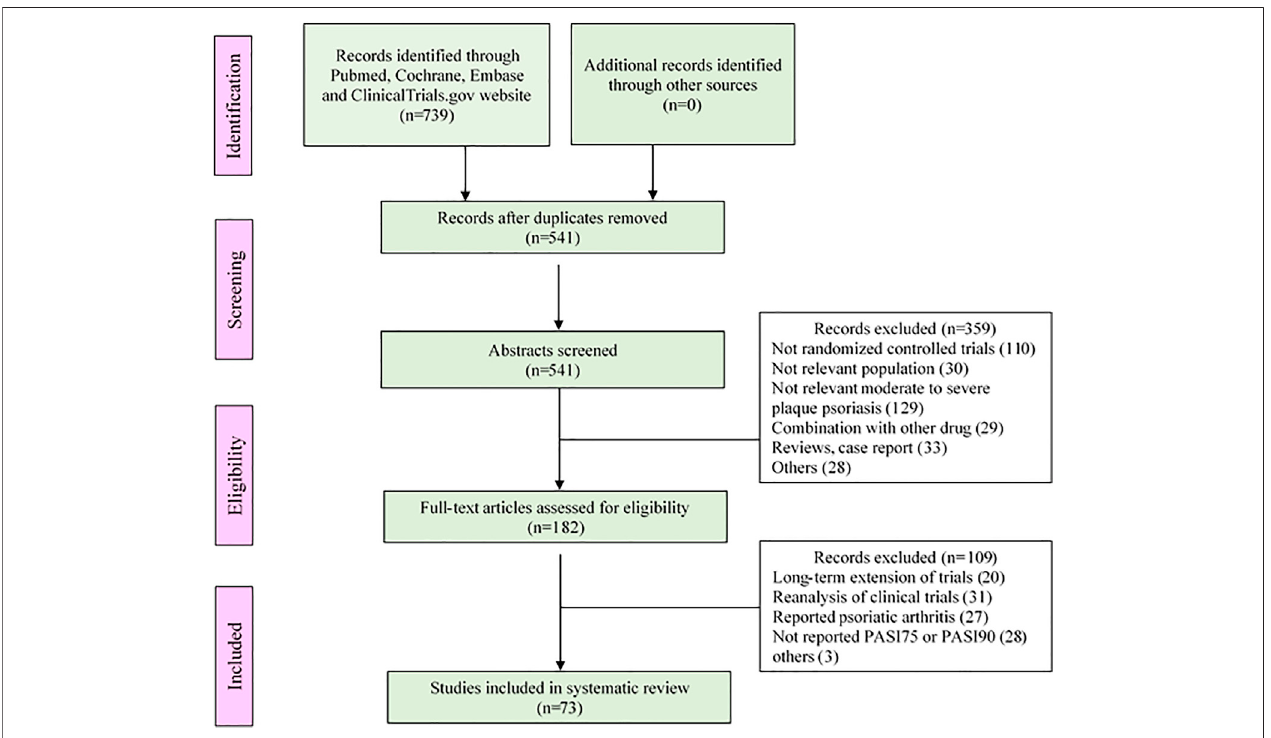
FIGURE 1 | The fl ow chart of study